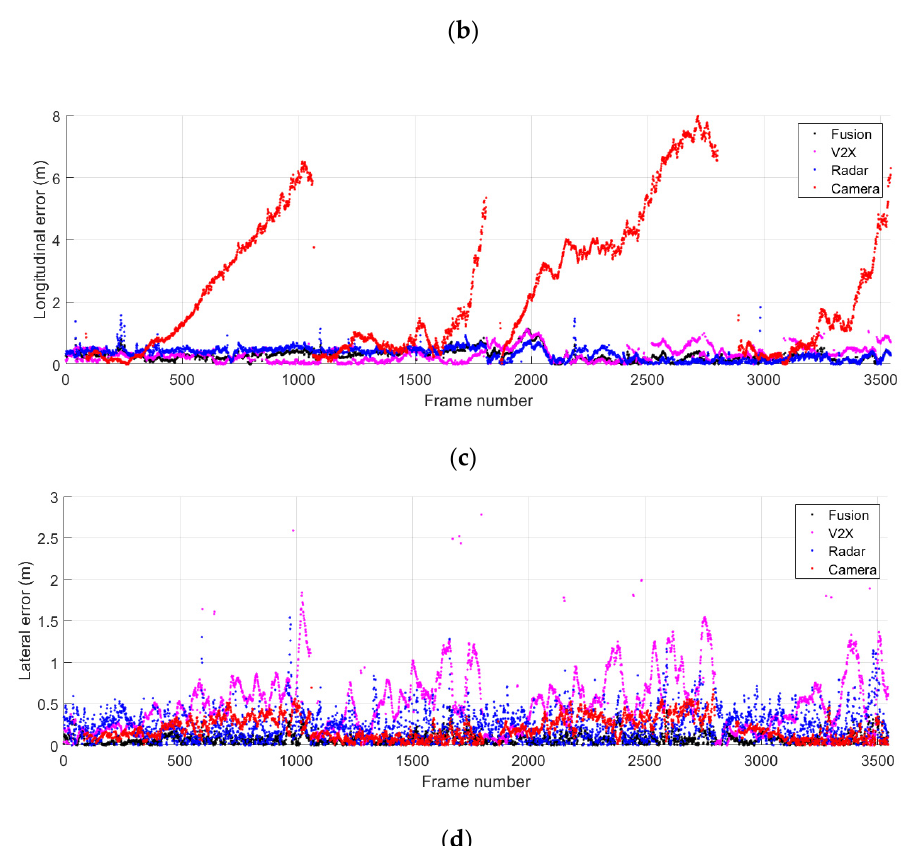
Figure 11. Relative distance to the remote vehicle during the normal driving scenario 2. ( a ) Ground truth longitudinal distance; ( b ) ground truth lateral distance; ( c ) absolute error for longitudinal distance estimates; ( d ) absolute error for lateral distance